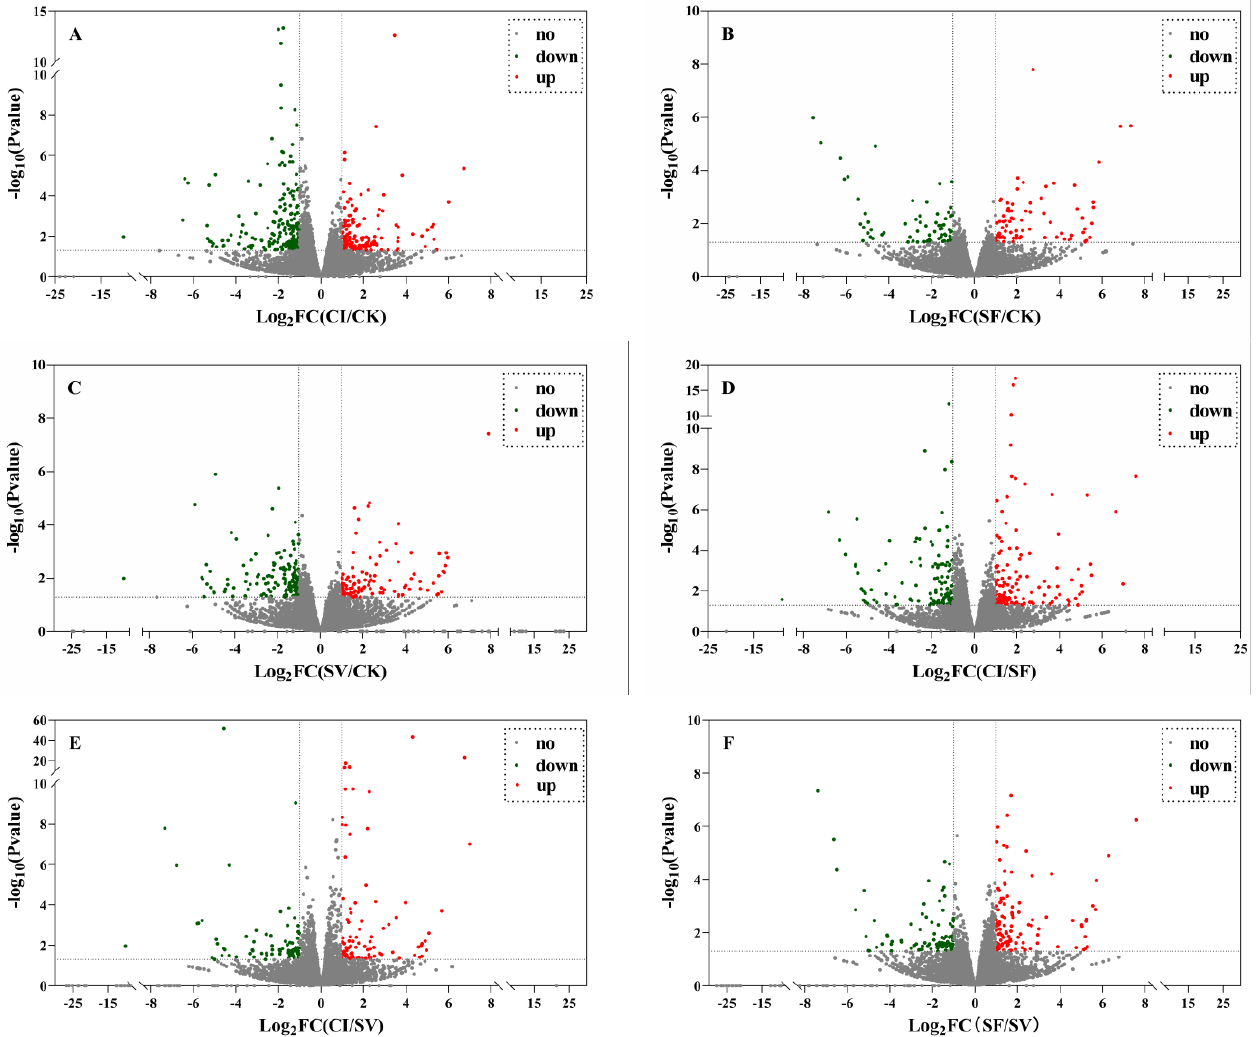
Figure 2. Volcanic plots of DEGs in each combination group. RRSV-free BPH were treated with Tween-80 (CK) or Metarhizium anisopliae YTTR (SF) and RRSV-carrying BPH were also treated with Tween-80 (SV) or M. anisopliae YTTR (CI), respectively. After 12 h, RNA-seq was performed. The expression of DEGs among the four treatment groups (CK, SF, SV, and CI) were compared with any two treatment groups. CI vs. CK, SF vs. CK, SV vs. CK, CI vs. SF, CI vs. SV, and SF vs. SV were defined. ( A – F ) respectively means the comparison group of CI vs. CK, SF vs. CK, SV vs. CK, CI vs. SF, CI vs. SV, and SF vs.